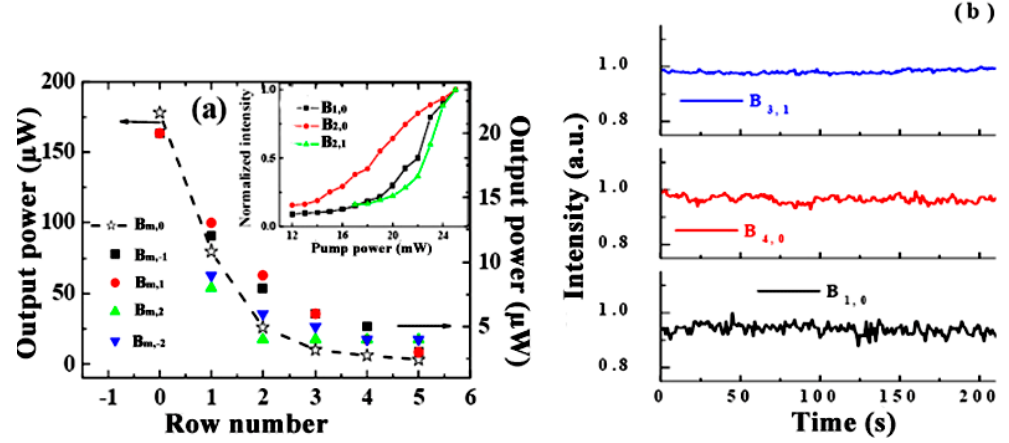
Figure 18. ( a ) The output power of sibebands on the B m,0 , B m,1 , B m, − 1 , B m, − 2 , B m,2 , with pump power of 0.1 mW and 25 mW for Beam 1 and Beam 2, respectively. The inset shows the power dependence of three different sidebands, B 1,0 , B 2,0 , and B 2,1 , on power of Beam 2; ( b ) The power stabilities of three sidebands B 3,1 , B 4,0 and B 1,0